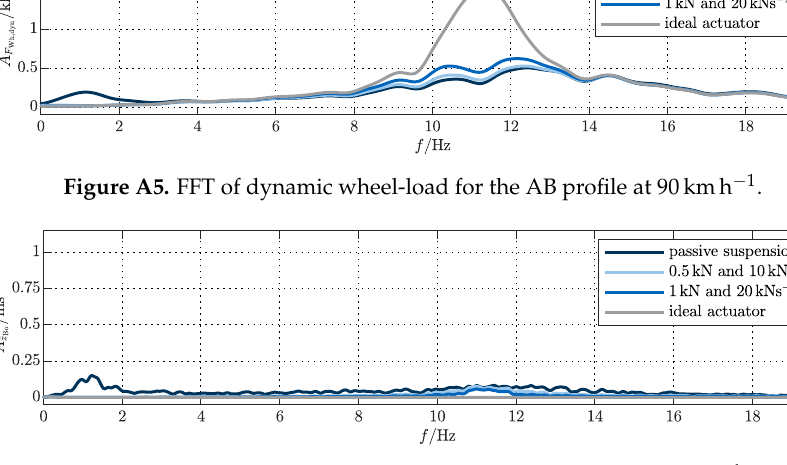
Figure A6. FFT of body acceleration for the AB profile at 45kmh − 1 .